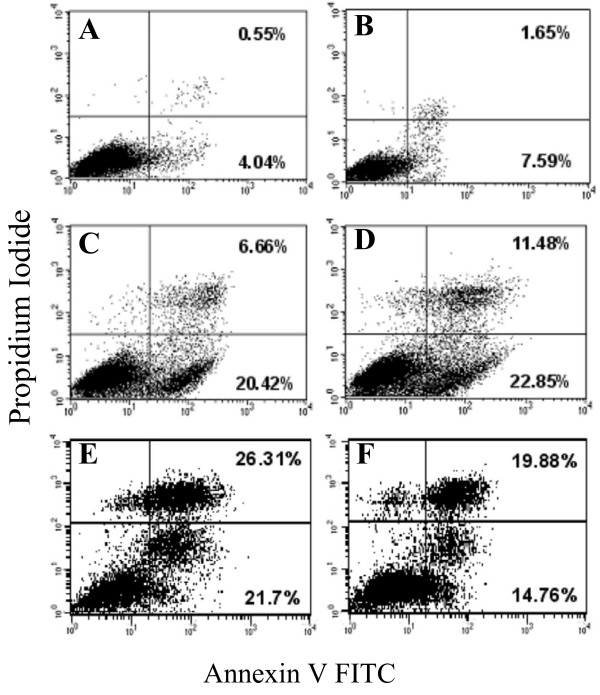
Amyloid-tau treatment induces rat hippocampal cell apoptosis. Flow cytometric analysis of primary hippocampal cells after treatment with 2 μM formaldehyde-treated tau. The percentage of apoptotic cells were characterized as those that stained with Annexin-V and excluded PI (see Materials and Methods). (A) Control cultured in DMEM without serum. (B), (C) and (D) represent the results of cells exposed to 0.1%-formaldehyde treated amyloid-tau for 24, 48, and 72 h, respectively. (E) and (F) represent cells incubated for 72 h with 0.05%- or 0.01%- formaldehyde-treated tau, respectively. Data represent the mean values of three independent experiments.